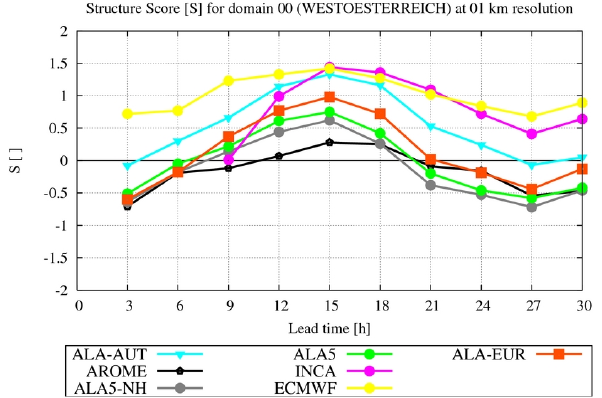
Figure 5. Mean values for SAL structure component S as a function of lead time for di ff erent models (verification period